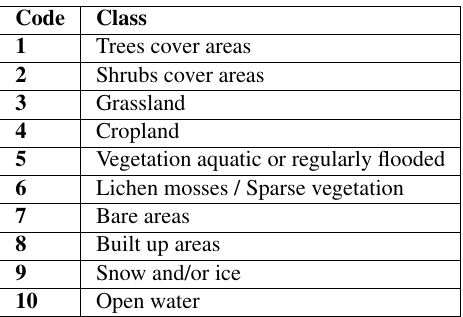
Table 1. CCI Africa Prototype